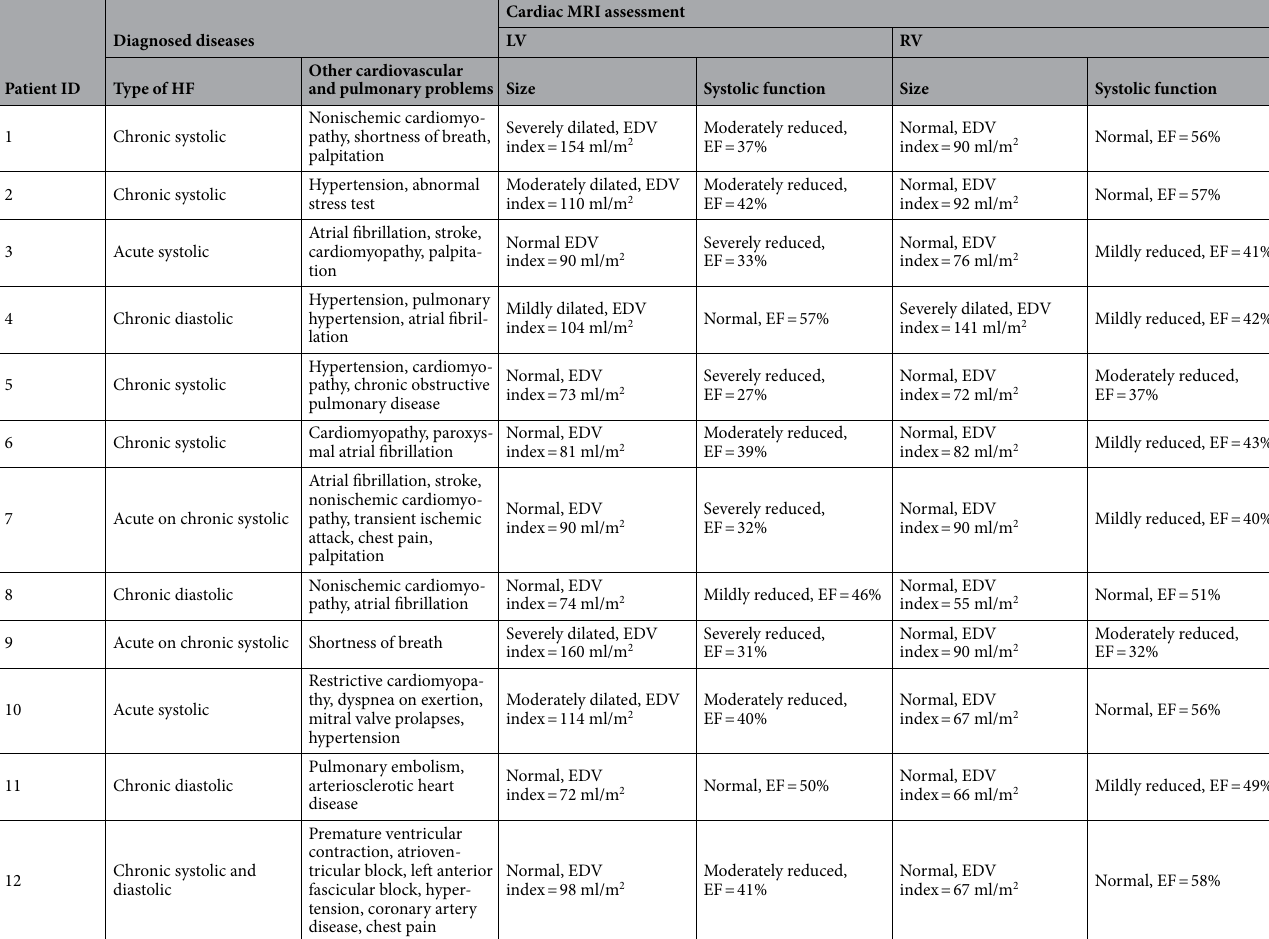
Table 1. Diagnosed diseases and cardiac MRI assessment of the recruited HF